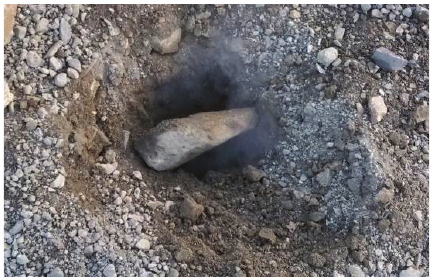
Figure 3: Blast cavity after blasting.